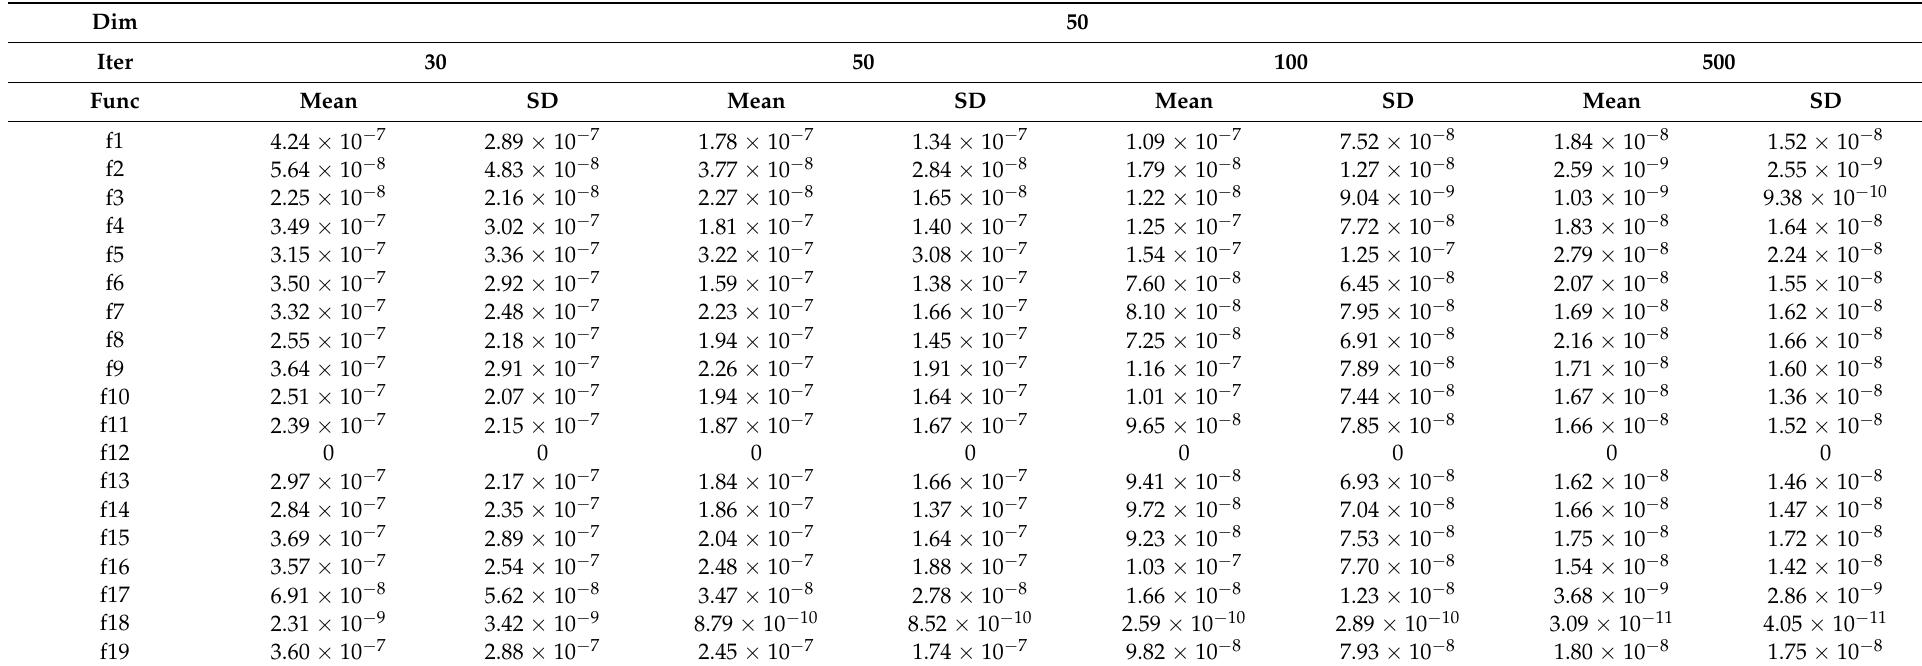
Table 8. DMOA: Results of the experiments for 50